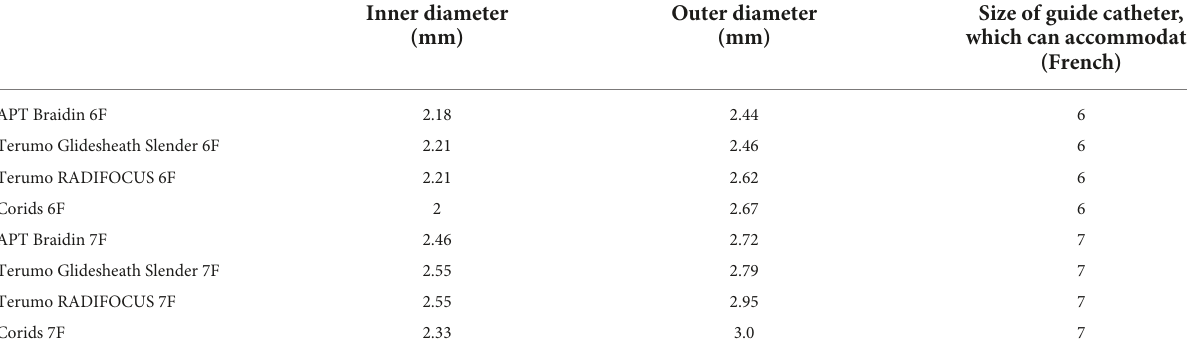
TABLE 1 Inner and outer diameters of commonly used 6 and 7F radial sheath.